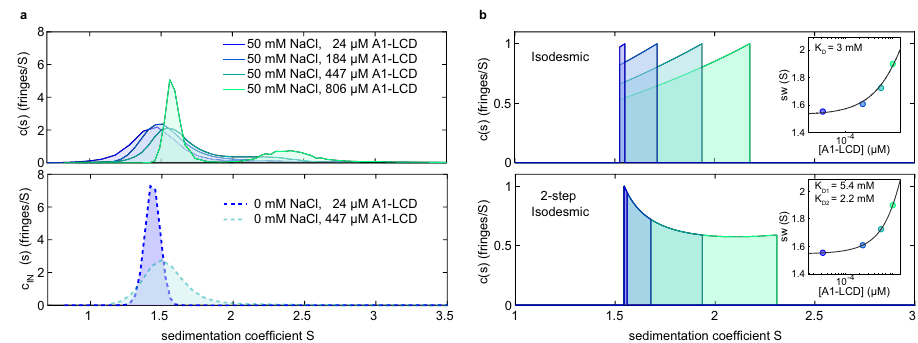
Fig. 4 The A1-LCD forms small oligomers in the dilute phase. a Normalized SV-AUC sedimentation coef fi cient distributions as a function of A1-LCD concentration. In samples with 50 mM NaCl, and approaching the saturation concentration, a second peak appears, shifts to higher molecular weight, and increases in intensity, implying that the size distribution of A1-LCD molecules shifts from mostly monomer to encompass also higher-order assemblies. b An isodesmic assembly model poorly accounts for the shape of the sedimentation pro fi le as a function of concentration. The weight-averaged sedimentation coef fi cient as a function of concentration is fi t to an isodesmic model (inset). A model with initial low-af fi nity association followed by higher- af fi nity addition of monomers qualitatively agrees with the experimental data. The weight-averaged sedimentation coef fi cient as a function of concentration is fi t to a two-step isodesmic model (inset). Colors in b correspond to colors in